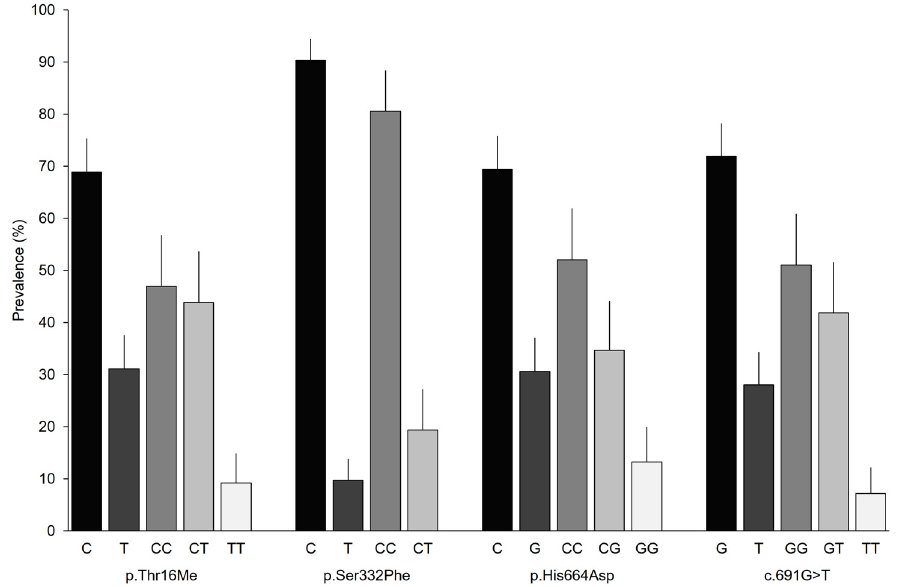
Figure 1. Allelic and genotypic prevalence based on the analyzed variant in the AOC1 gene. Error bars represent 95% CIs.